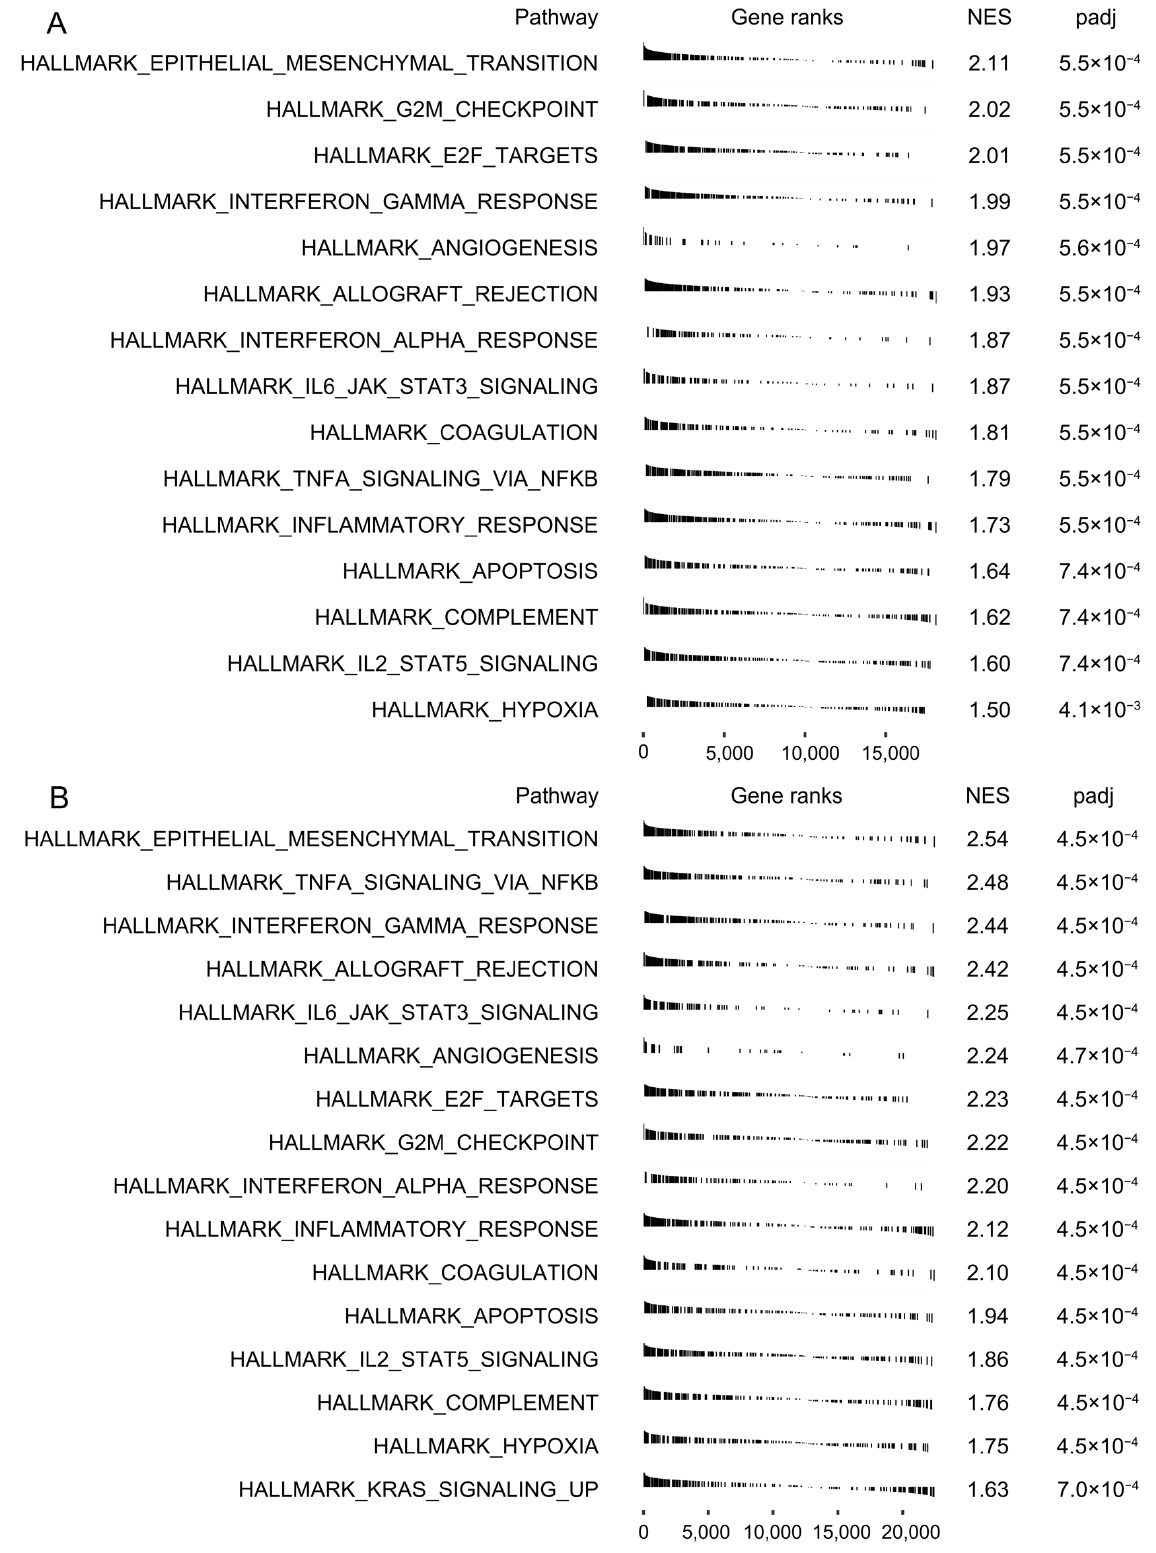
Figure 6. Biological processes associated with the expression of CRNDE in bulk RNA-seq. GSEA of hallmark pathways between the high- and low-expression groups in ( A ) TCGA and ( B ) CGGA.